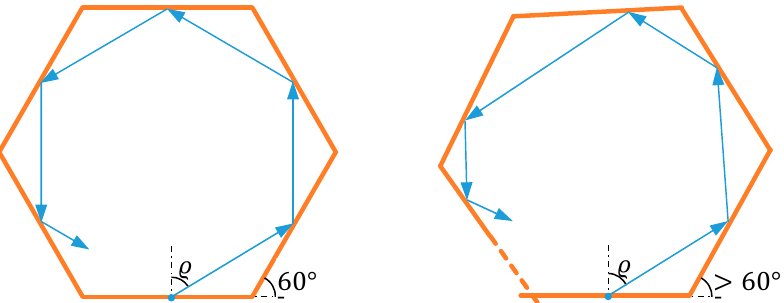
Figure 2. Reflections in a polygon. Left: regular polygon, right: polygon with deviations of the corner angles. The effect on the beam propagation is strongly exaggerated.